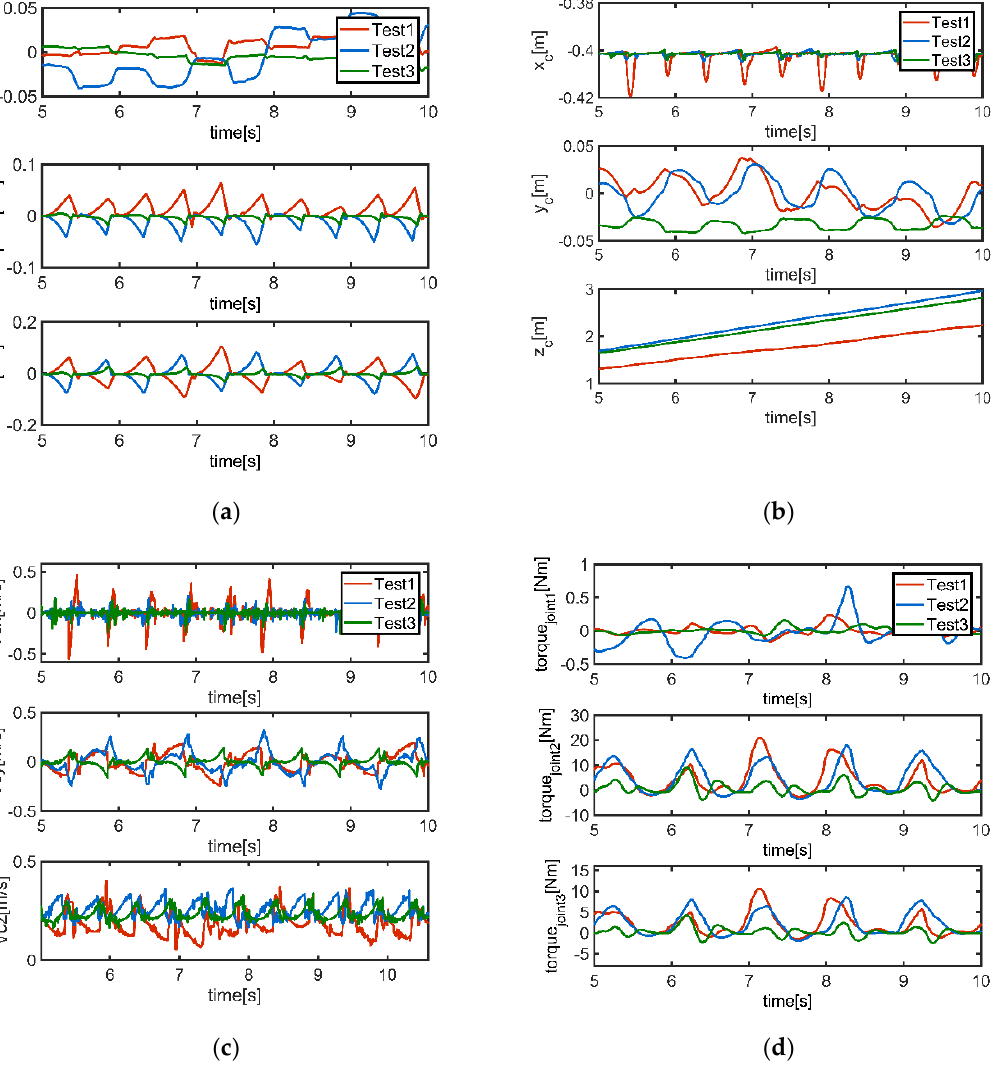
Figure 18. Sensor data of the motion in Simulation 2: ( a ) posture angles; ( b ) positions; ( c ) velocities of the body; and ( d ) driving moments of the left hind leg.